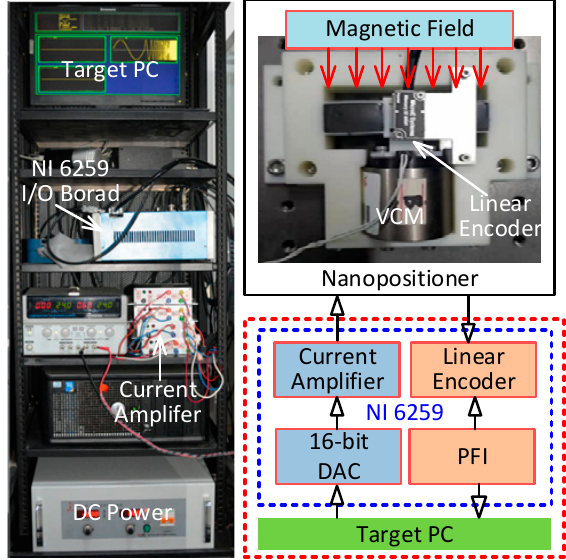
Figure 10. Experimental setup of the nanopositioner prototype.